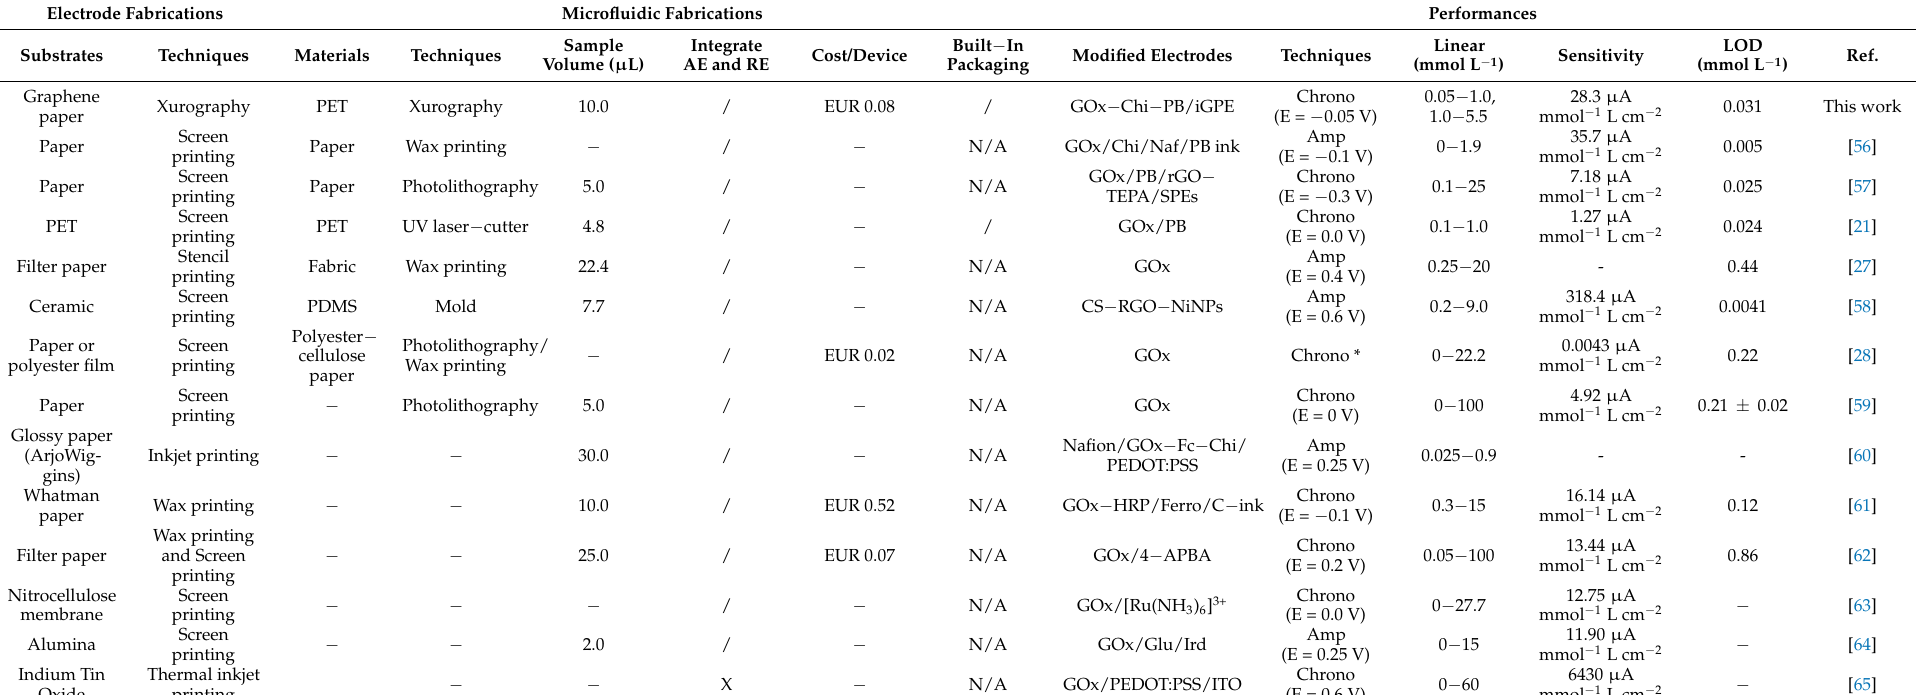
Table 1. The analytical performance of disposable electrode corporate with and without microfluidic by various procedures for glucose